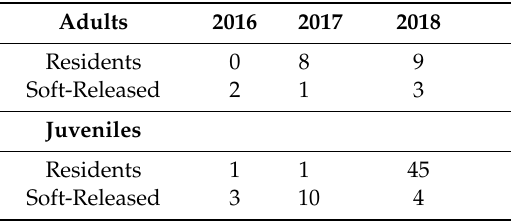
Table 1. Number of resident and translocated Texas horned lizards ( Phyrynosa cornutum ) tracked on Tinker Air Force Base, OK, between